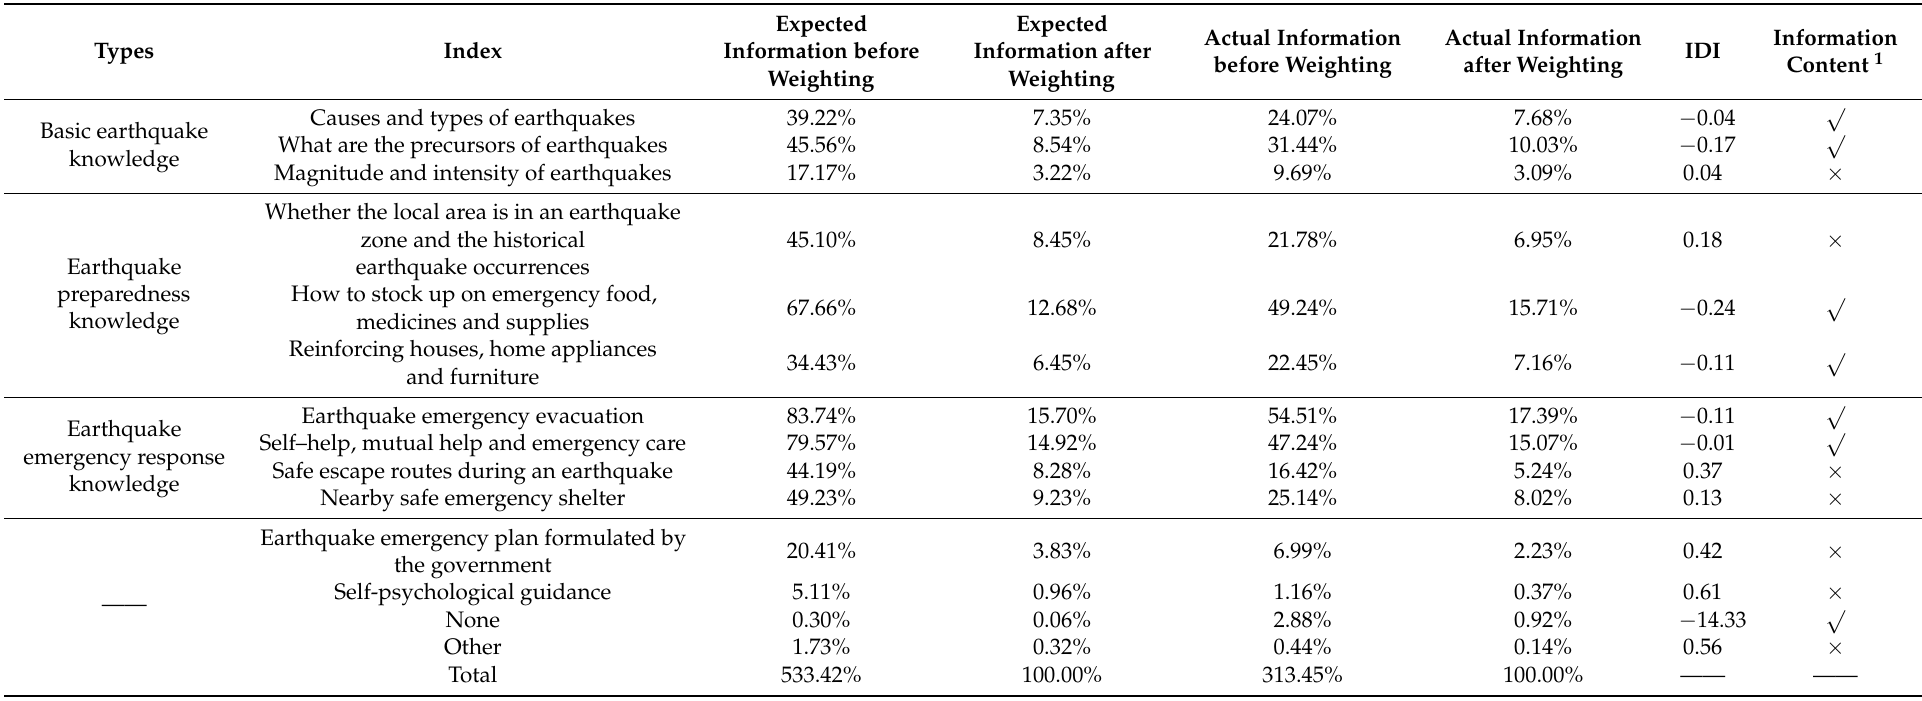
Table 4. Information deviation index in the prodromal stage of an earthquake